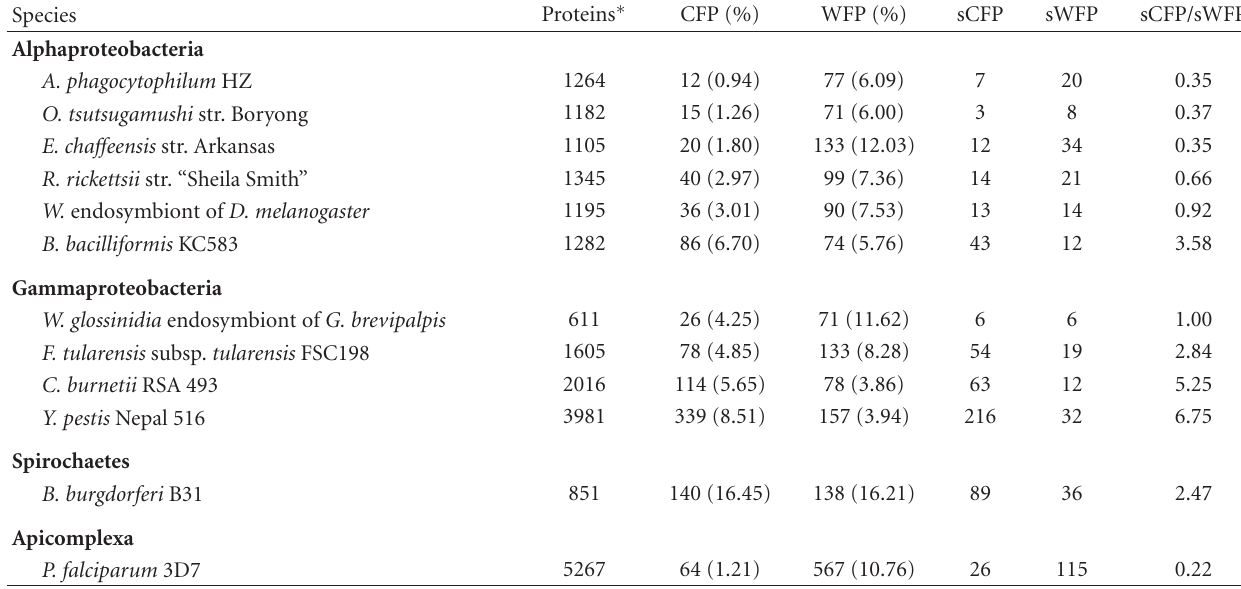
Figure 3: Abundance and distribution analysis of cysteine (left panel) and tryptophan residues (right panel) in secreted proteins belonging to 28 di ff erent families and secreted by many species of pathogenic and non/pathogenic Proteobacteria. The protein families were arranged by cysteine abundance and distribution to optimize the visualization of patterns. Table 1: Abundance of proteins devoid of cysteine residues (CFP) or tryptophan residues (WFP), included those predicted as secreted (sCFP and sWFP), in 12 species of arthropod-borne